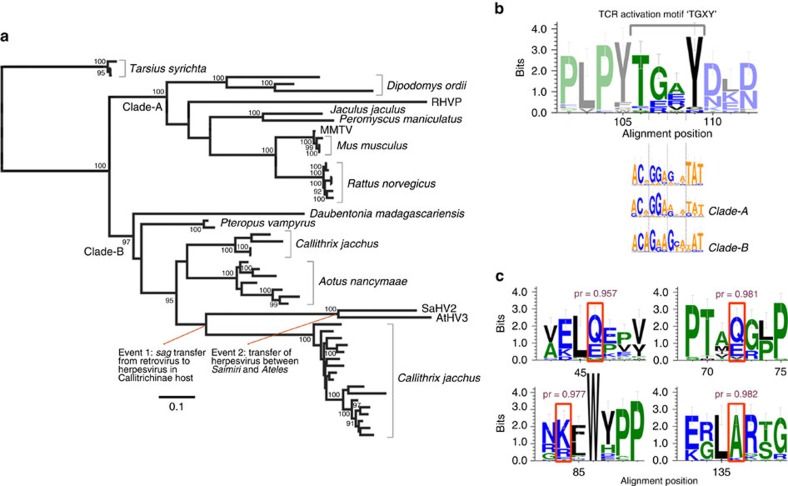
Evolutionary history and selection analysis of sags.(a) A phylogeny of gag, pro, pol, env and sag genes. Clade-A shows the rodent ERVs, and RHVP, while clade-B is the predominantly primate clade that also contains AtHV3 and AtHV2. The rooting was determined by reconstructing a tree from an alignment of pol from sequences included in this tree as well as 11 outgroup sequences. The scale bar shown represents the number of amino-acid substitutions per site and posterior probability values above 90% are indicated at each node. (b) WebLogo of a region of the alignment used to reconstruct the tree in a, including the underlying codons on the first line. The region shown is the crucial TCR activation motif. The subsequent lines show the codons for the same region using only clade-A or clade-B sequences, including a larger taxon set compared with the representative subset used for the tree. (c) Results of the Branch-Site test of positive selection, assessing the likelihood of positive selection at individual sites of the branch leading to SaHV2/AtHV3. The WebLogo was generated using the expanded clade-A alignment. The highlighted sites have a dN/dS>1 with a significant posterior probability, denoted as pr.